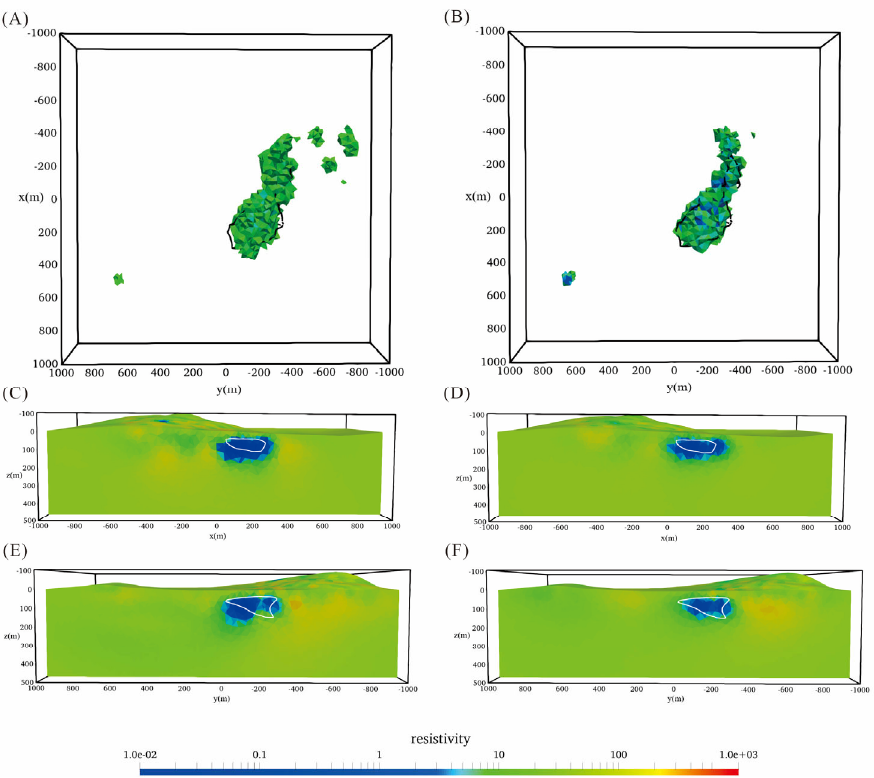
Figure 12. Inversion results for the sulfide ore body model. ( A , C , E ) are the z component inversion result at z=50 m, y= − 150 m and x=100 m ( B , D , F ) are the multi ‐ component result at the same locations.